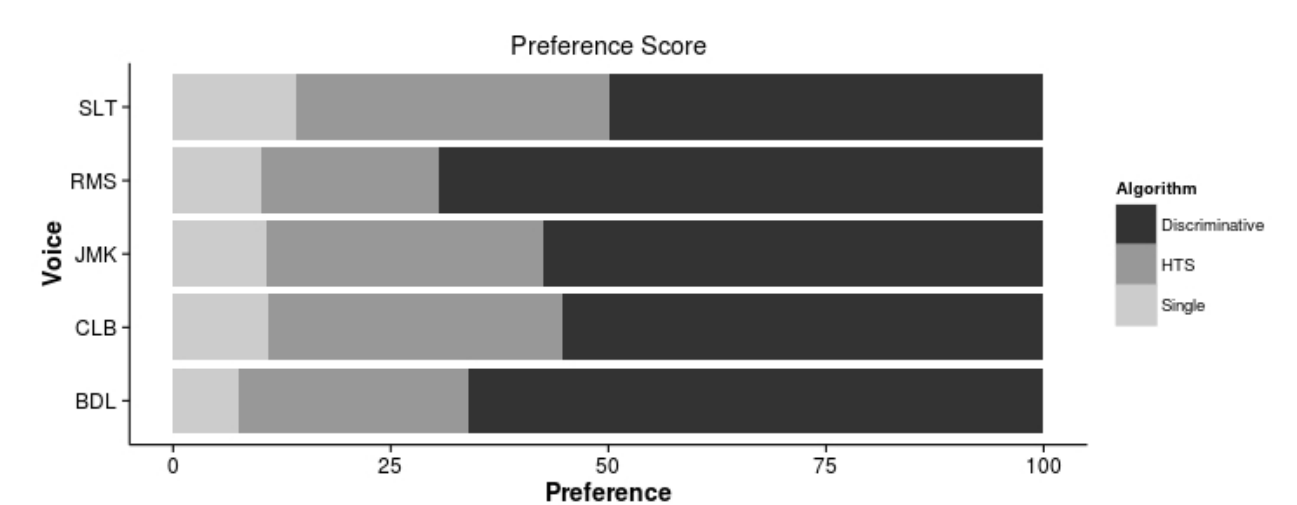
Figure 5. Preferece score for the HTS voices and the non-discriminative (single) and discriminative